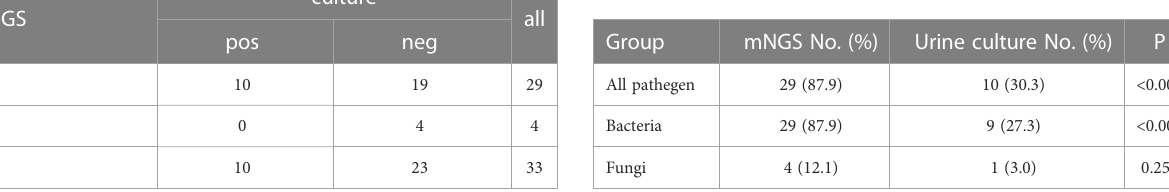
TABLE 3 Comparison of diagnostic performance in pathogen detection between mNGS and culture